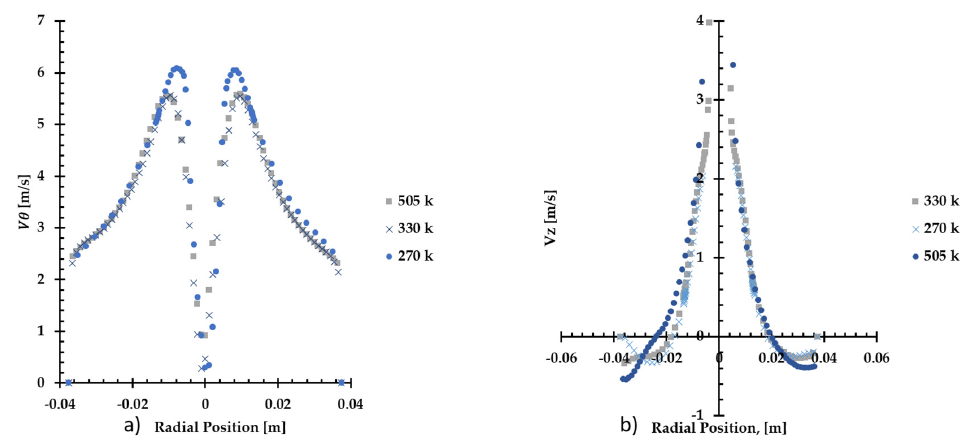
Figure 3. Geometric dimensions and domain mesh.